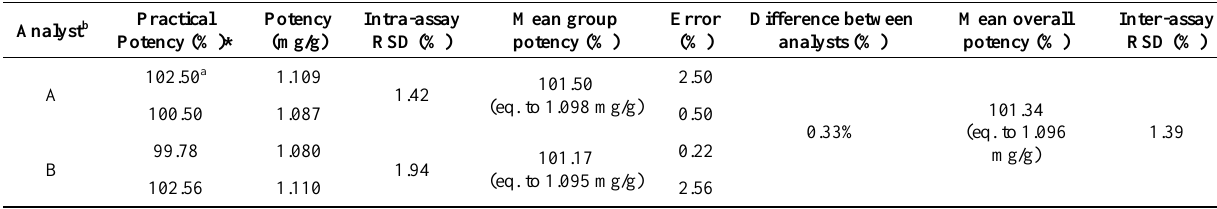
Table 4. Between-analyst (ruggedness) result of Gentamicin Sulfate in large assay plates for two-dose